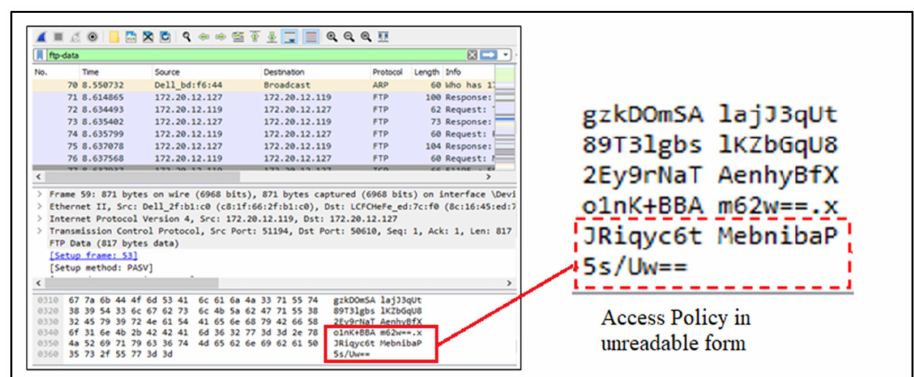
Figure 8. Packet capture using Wireshark after access policy